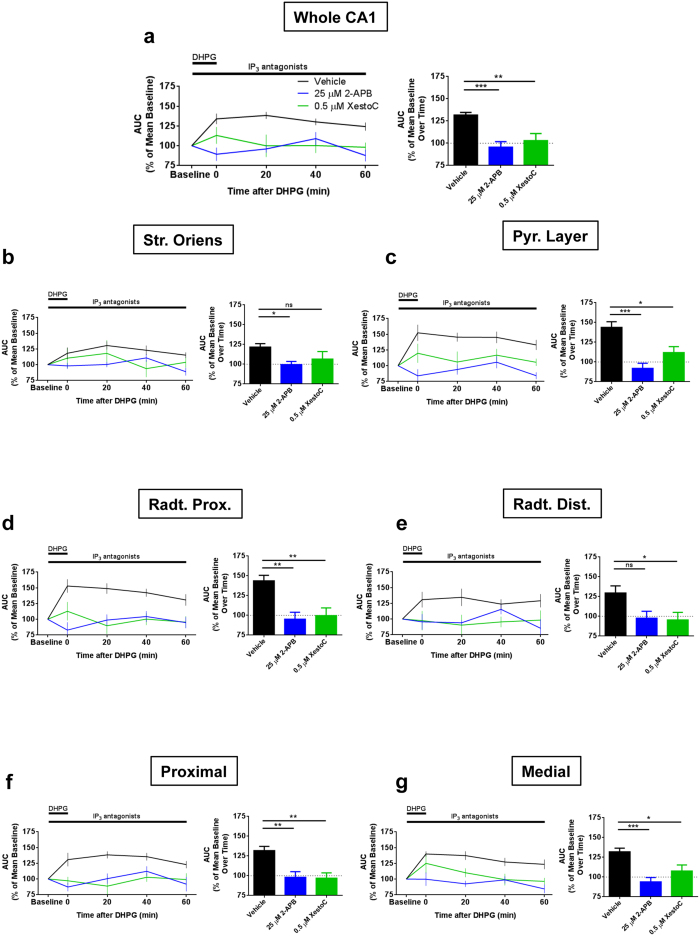
Long-lasting increase of fIPSPs after DHPG application is mediated by IP3 receptors activation.DHPG failed to increase fIPSPs in all CA1 (a) and specifically in its different sub-regions (b–g) in presence of the cell-permeable IP3 receptors blockers 2-APB or Xestospongin C (XestoC). In all figures, left panel shows the time course, while right panel is showing mean over time. Statistical analysis in right panel figures is one-way ANOVA followed by Dunnet post-hoc test. Vehicles of both IP3 receptors antagonists have been pooled together since they are not different. n = (slices, mice): Vehicle group = (11, 9), 2-APB group = (5, 5), Xestospongin C group (5, 3). Data are mean ± s.e.m. *p < 0.05, **p < 0.01, ***p < 0.001, ns = not significant.